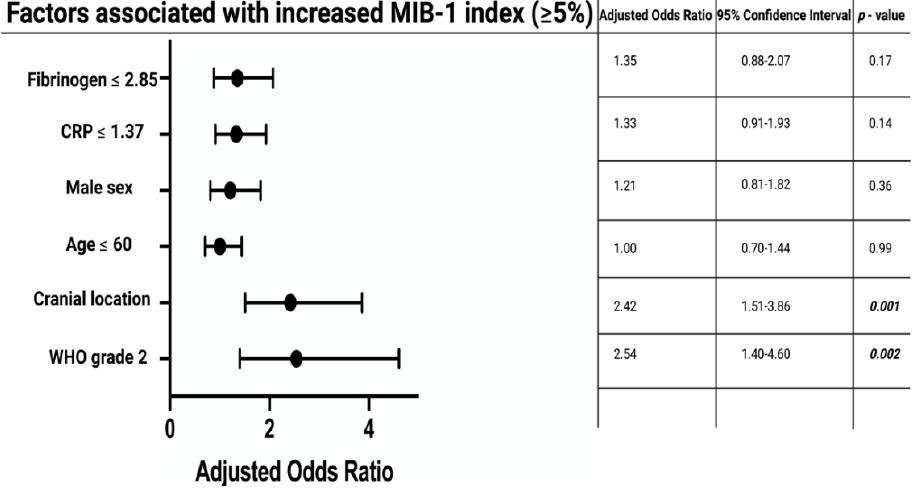
Figure 3. Forest plots from multivariable binary logistic regression analysis: cranial meningioma location, and WHO grade 2 are independent predictors of increased MIB-1 indices. p -values in italics and bold outline statistically significant results.